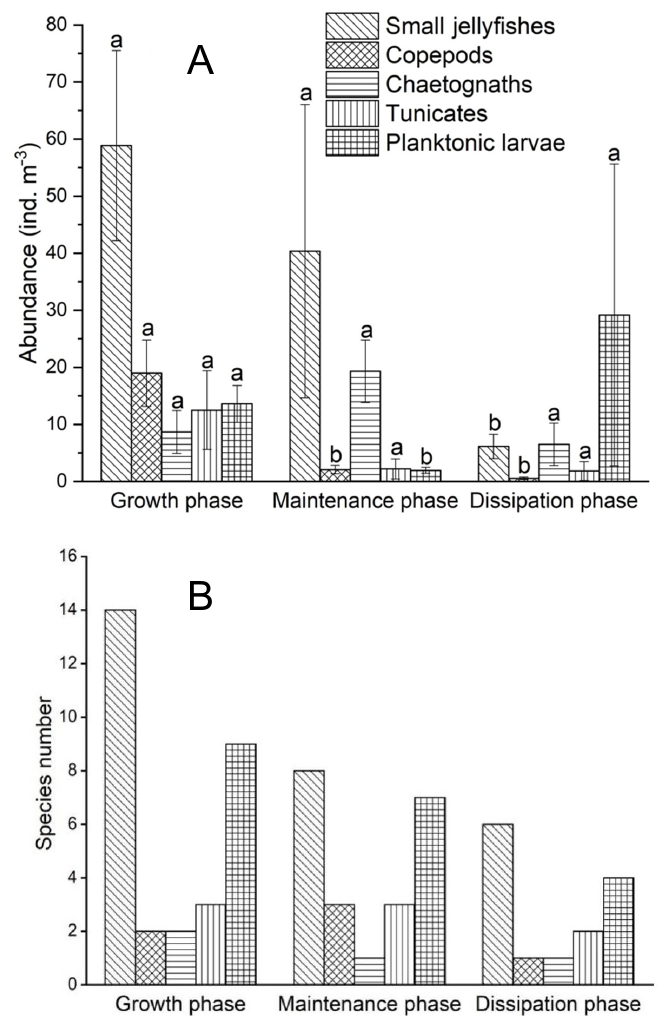
Figure 5. The abundance of zooplankton (total and main group, ( A )) and changes of diversity (total number and main group, ( B )) in different phases of P. donghaiense bloom. Data were presented as the mean values ± SE, with the different letters indicating significant ( p < 0.05) differences among the different phases.